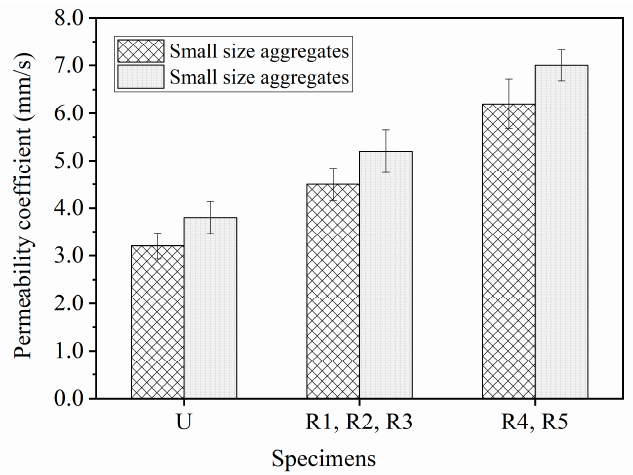
Figure 7. The permeability coefficients of pervious concrete specimens.